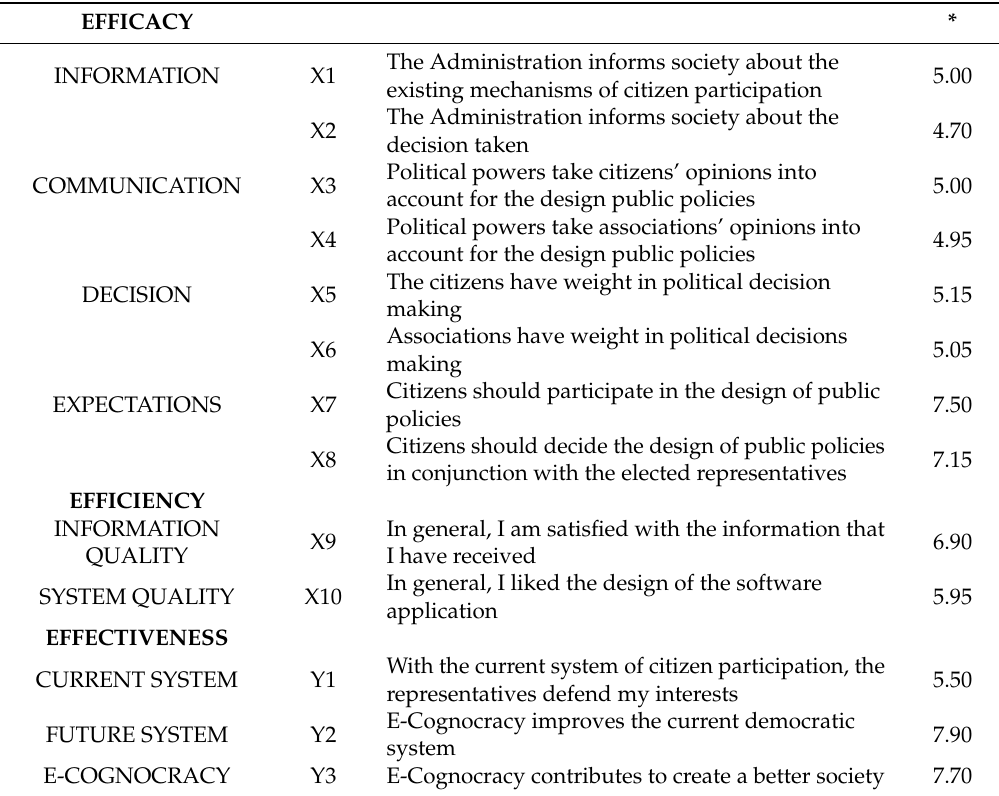
Table 7. Constructs and